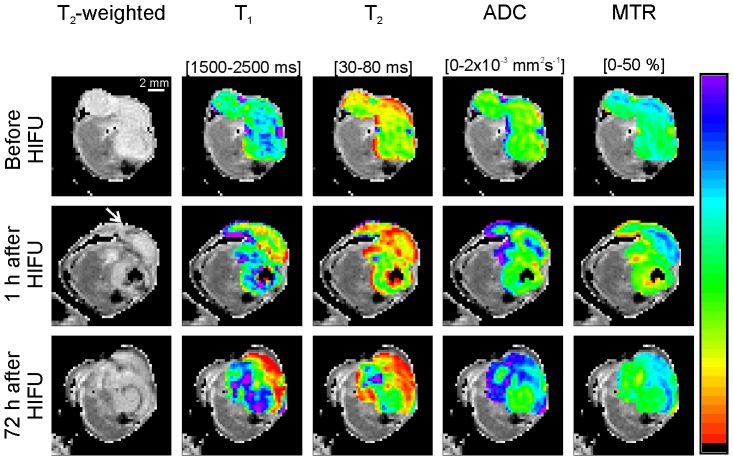
MRI parameter maps before and longitudinally after HIFU treatment.Representative example of multiparametric MRI of the hind limb region of a HIFU-treated tumor-bearing mouse before and 1 h and 72 h after HIFU treatment. T2-weighted images of an axial slice of the tumor-bearing paw are shown in the left panel. The hyper-intense tumor tissue is surrounded by hypo-intense muscle tissue. In the other panels the same T2-weighted images are displayed except that the tumor pixels are overlaid with MRI parameter maps. The parameter maps were scaled according to the color scale bar shown at the right-hand side of the figure. The corresponding parameter range for this scale bar is indicated above each panel. The approximate direction of the HIFU treatment is shown by the white arrow on the T2-weighted image, which was collected 1 h after HIFU treatment.